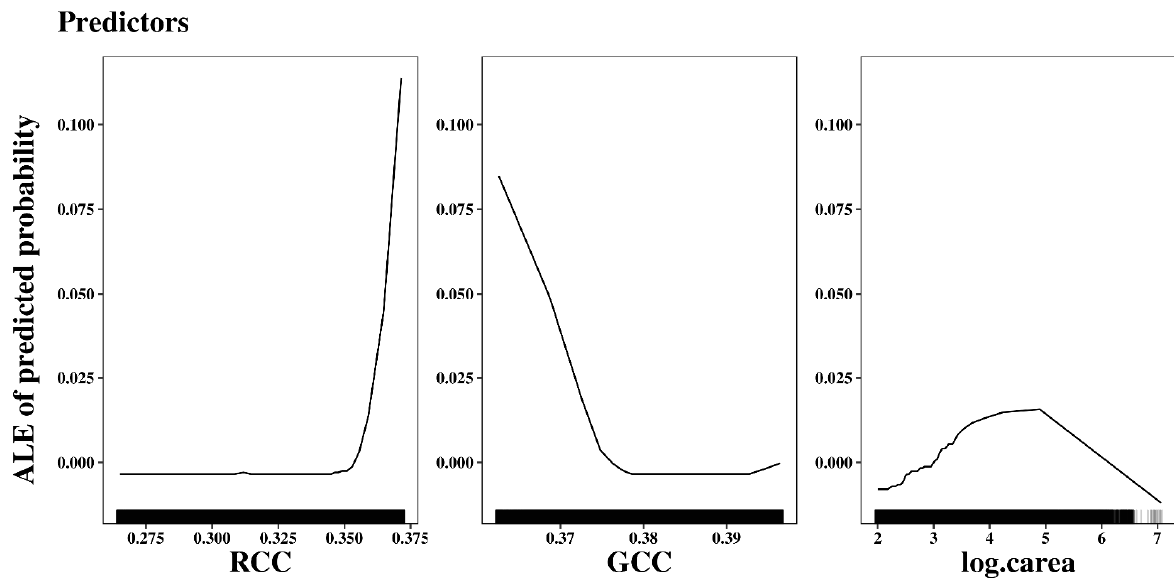
chromatic coordinate (RCC).